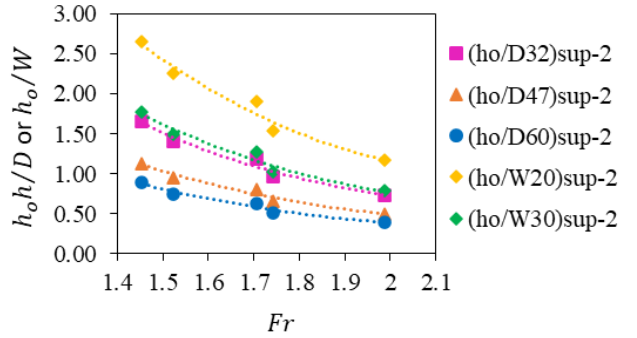
Figure 5. Flow forms of the non-dimensional water depth relative to the geometry for case C1 for the supercritical flow. The subscript “sup-2” indicates the supercritical flow over the horizontal channel bed. Table 6. Non - dimensional wall - jet height ℎ 𝑗𝑒𝑡∗ ( = ℎ 𝑗𝑒𝑡 ℎ 𝑜 ⁄ ) relative to the upstream water depth ( ℎ 𝑜 ) for the supercritical flow over the horizontal channel bed for case C1.